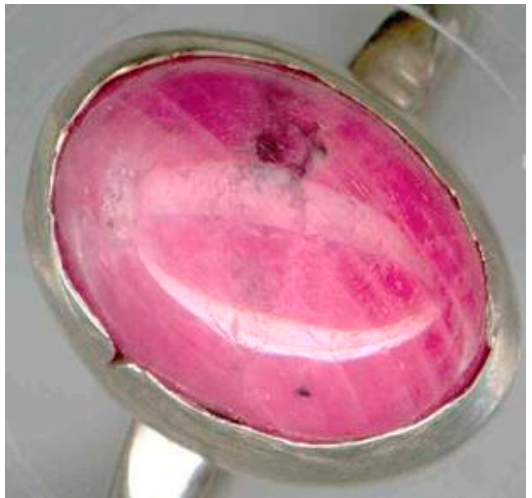
Figure 14. Cabochon quality ruby from Paranesti Drama. Photograph courtesy of V. Melfos.